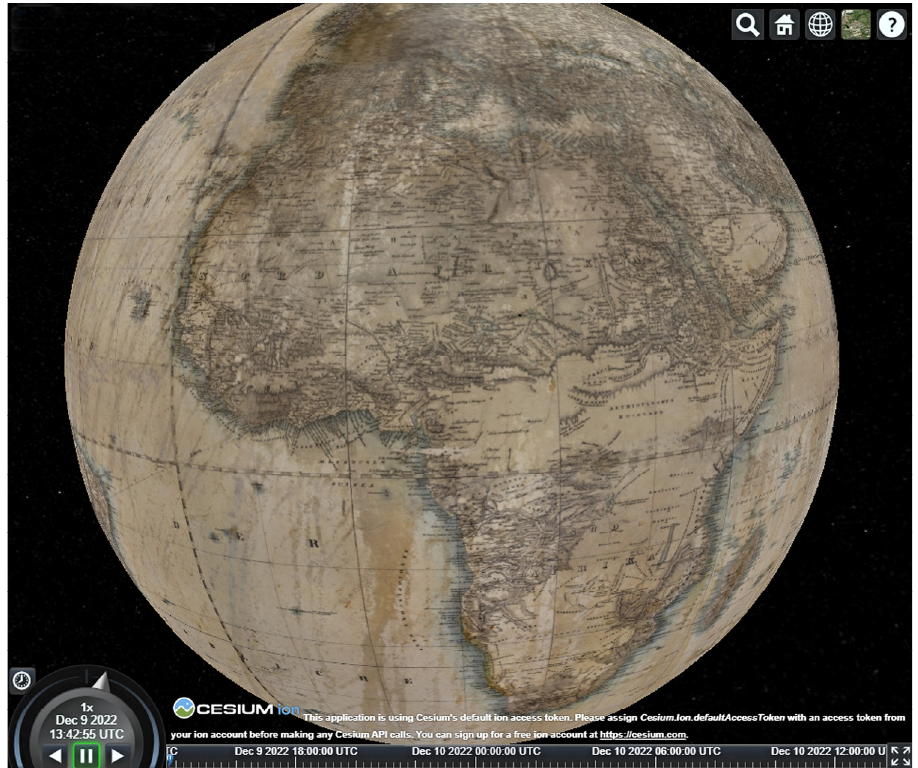
Figure 9. Example of access to the globe in the web browser. Source: Map Collection of the Faculty of Science, Charles University, Cesium.